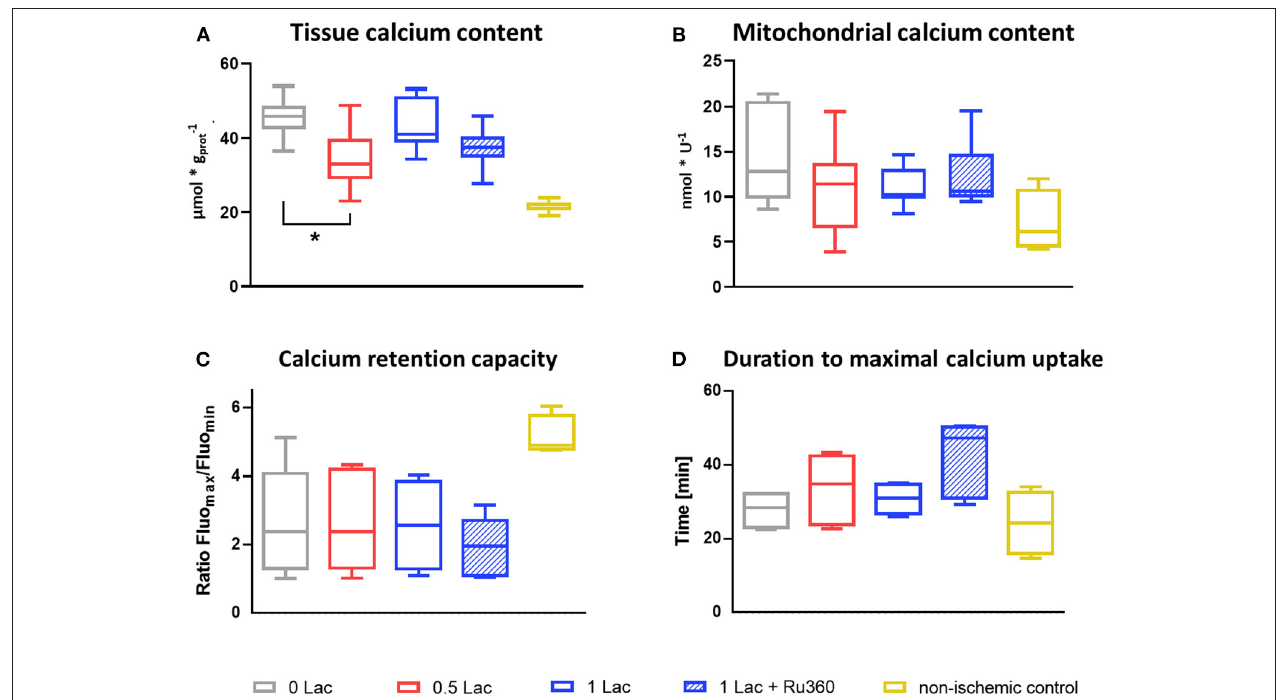
FIGURE 6 | Calcium content and mitochondrial calcium retention capacity. (A) Cardiac tissue calcium content at 60min of reperfusion, n = 6–14/group, non-ischemic controls ( n = 7) are historical data from the lab (no stats performed) (B) Mitochondrial calcium content at 10min of reperfusion, n = 6–8/group, except non-ischemic controls n = 4 (C) Mitochondrial calcium retention capacity (measured in freshly isolated mitochondria after 10min of reperfusion) expressed as ratio of the maximal and minimal fluorescence [AU] after the addition of 0.3mM CaCl 2 , Mix 2. (D) Time between CaCl 2 addition (0.3mM, Mix 2) until minimal fluorescence value ( = duration to maximal calcium uptake by mitochondria). * p < 0.05; n = 4–6/group, except non-ischemic controls n = 4 (C,D) . Data are expressed as median, 25–75 percentiles, and